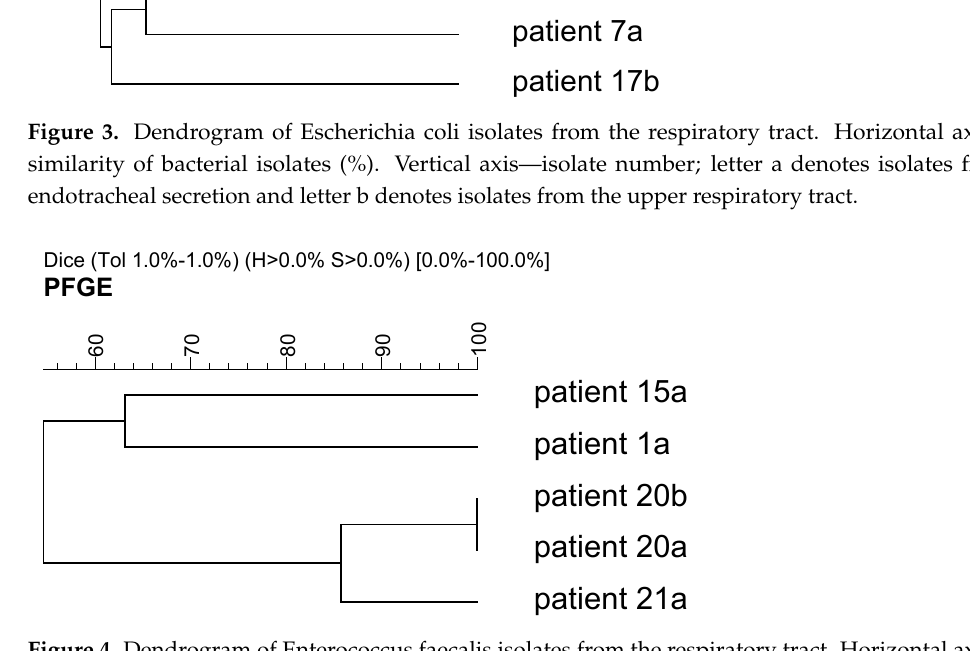
Figure 4. Dendrogram of Enterococcus faecalis isolates from the respiratory tract. Horizontal axis— similarity of bacterial isolates (%). Vertical axis—isolate number; letter a denotes isolates from endotracheal secretion and letter b denotes isolates from the upper respiratory tract.